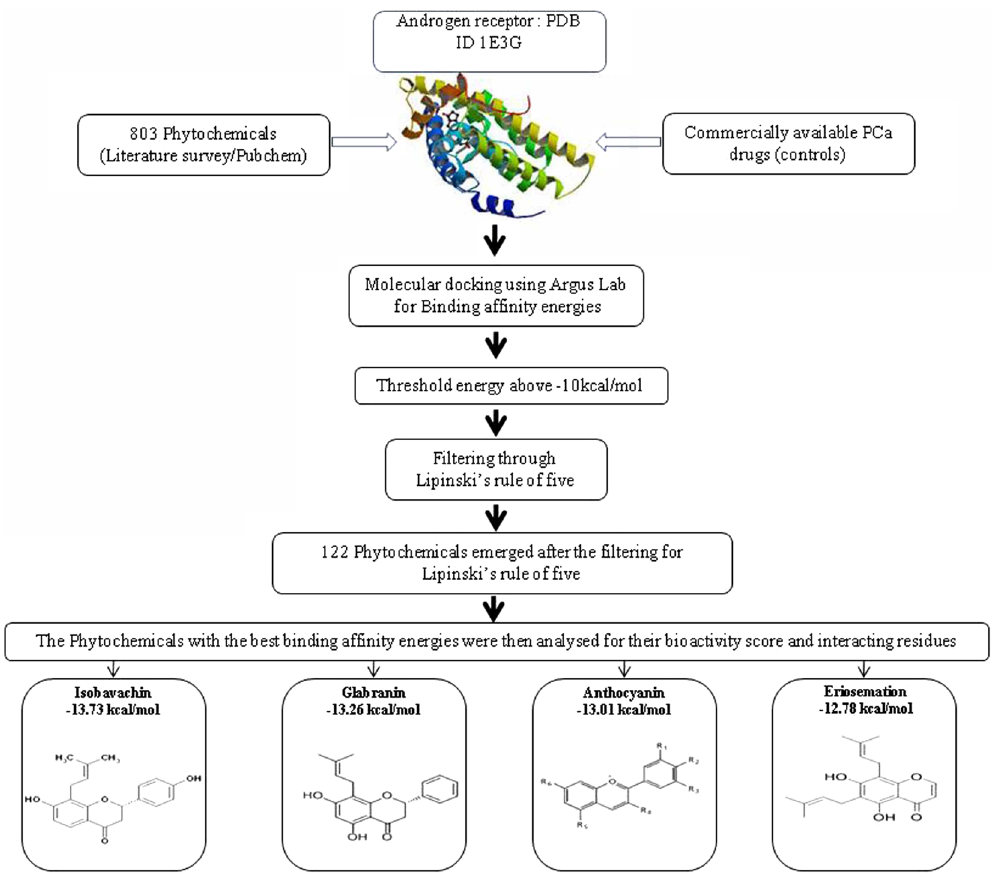
Figure 1. Graphical representation of the different approaches used in this